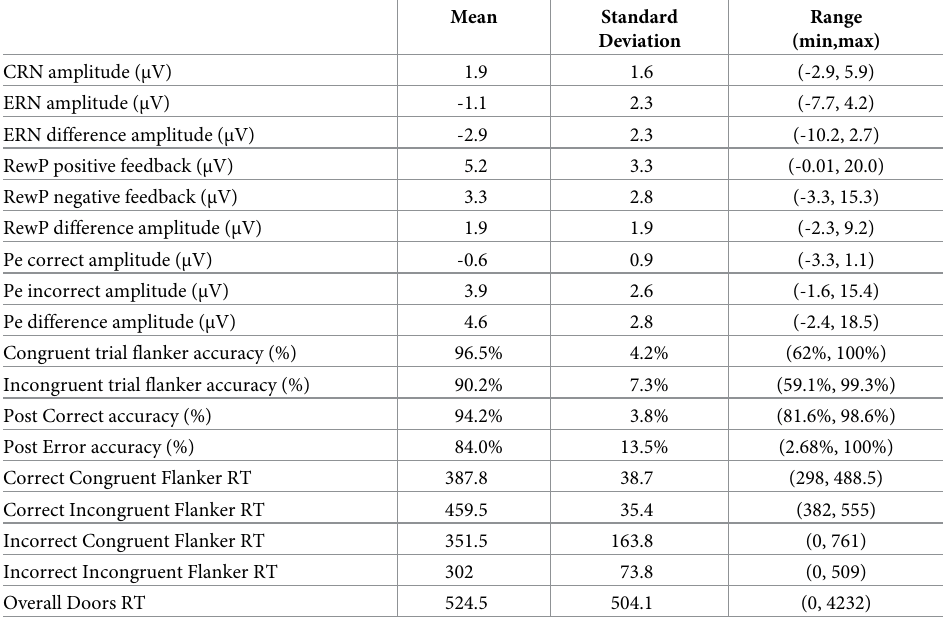
Table 1. Means and standard deviations for ERP components, task accuracy, and response time.